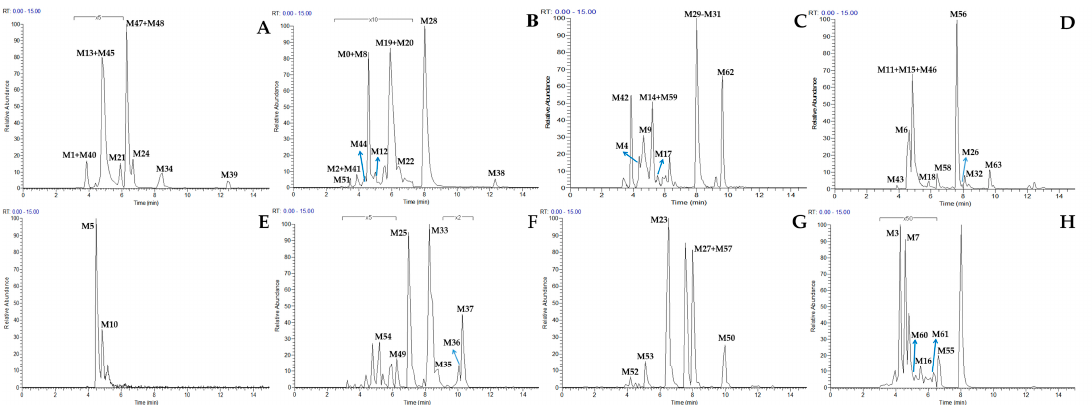
Figure 6. High resolution extracted ion chromatograms of genistin metabolites (( A – E ) for negative ion mode and ( F – H ) for positive ion mode): ( A ) m / z 253.0495, 283.0600, 299.0549, 447.0922; ( B ) m / z 269.0444, 349.0012, 415.1023, 431.0972; ( C ) m / z 225.0546, 227.0340, 241.0495, 257.0809,